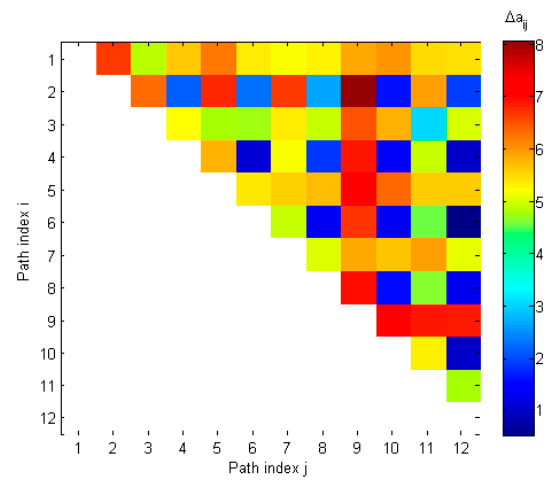
Figure 7. Distances between steering vectors in spoofing scenario 1. Table 4. Distances between steering vectors in spoofing scenario 1.